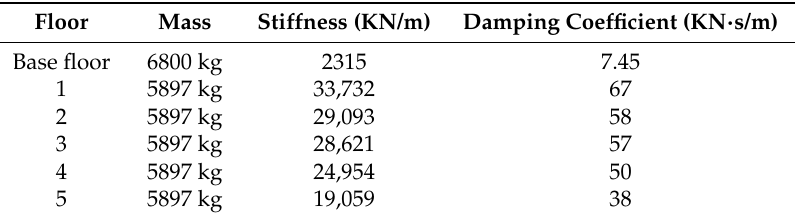
Table 2. Parameters for the base-isolated